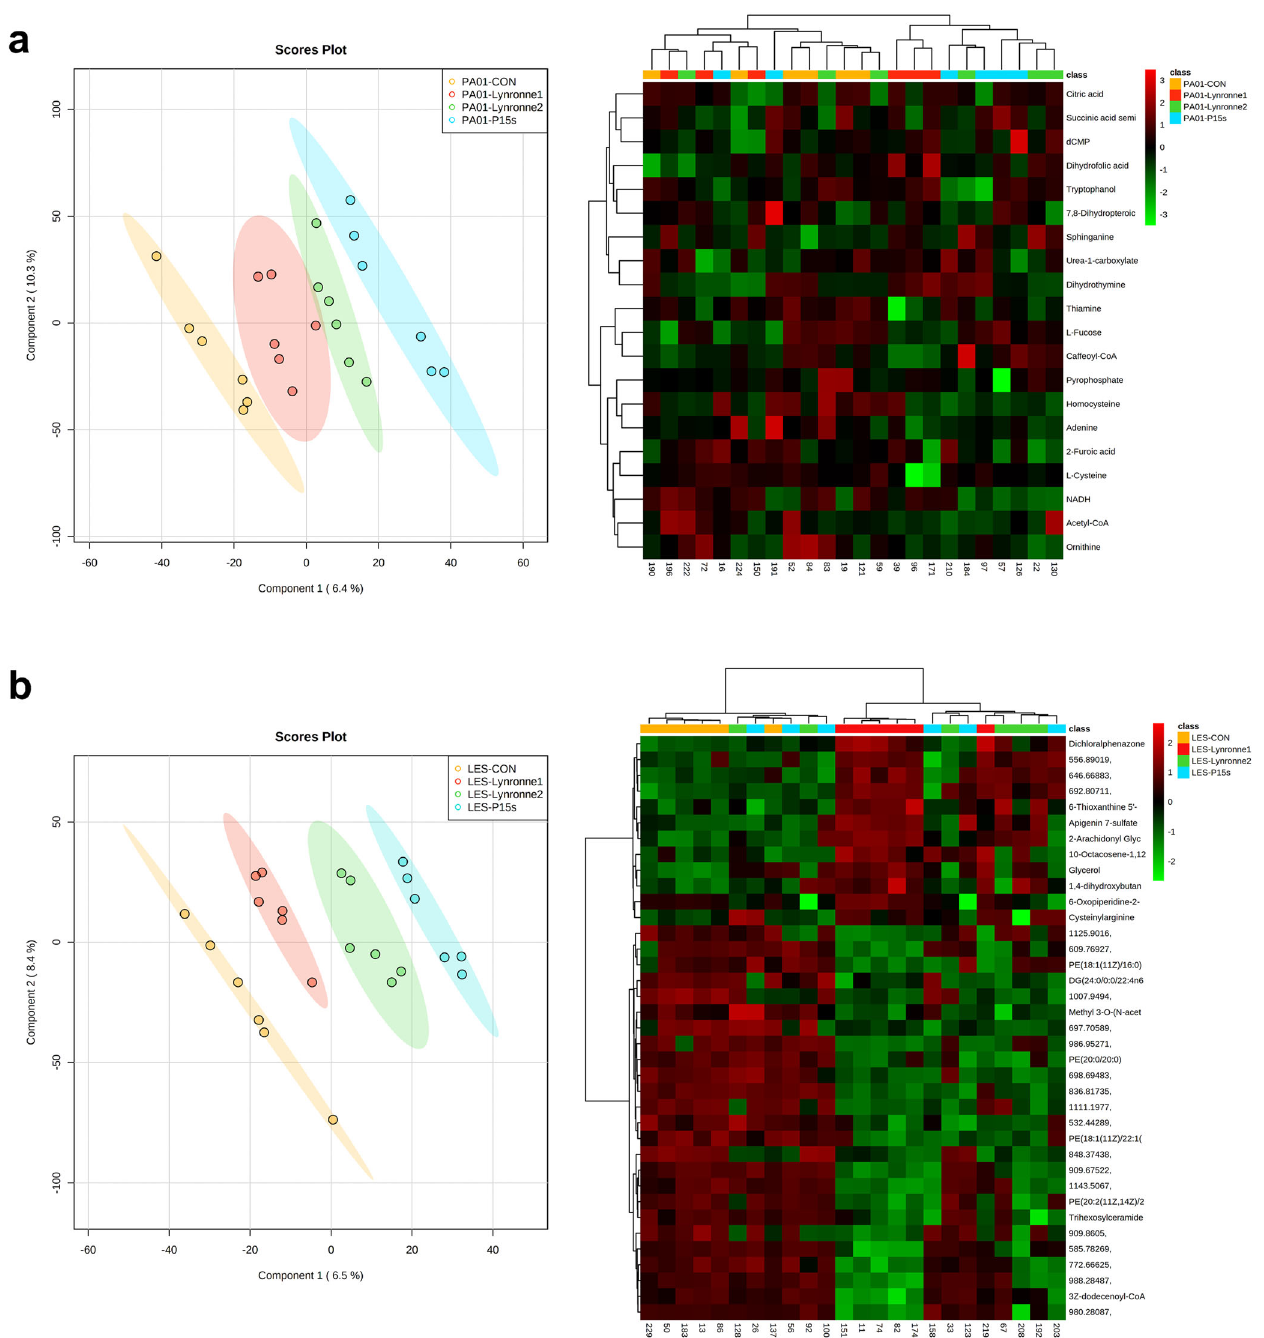
Fig. 6 Peptide-induced metabolic changes in PAO1 and LES431 cells. PLS-DA & hierarchical cluster analysis (HCA): heatmap for negative ionisation fl ow injection electrospray mass spectrometry (FIE-MS) generated based on the top 25 signi fi cant metabolites through one-way ANOVAs, for the peptide metabolite groups (Lynronne 1, Lynronne 2 and P15s) and the untreated ( a ) PAO1 and ( b ) LES431 metabolite group. Metabolites identi fi ed in FIE-MS-negative ionisation 60% after 24 h and 10% after 48 h (Fig. 8a). Following infection using ~1.17 × 10 4 or ~1.32 × 10 3 CFU/larvae PAO1. For the larvae with 10 3 CFU/larvae, survival rate with P15s treatment at 384 mg/ group infected with 10 4 cells; the death rate was 100 % at 24 h (Fig. 8a). Larvae infected with 10 3 cells had 50% survival at 24 h, kg signi fi cantly increased, in comparison to untreated infected larvae (pairwise comparison, P = 0.00467 ) . For statistical analysis, a but 100% of death at 48 h (Fig. 8b). Infected larvae treated with simple pairwise comparison was performed to compare the effect Lynronne 1 (32 mg/kg) or Lynronne 2 (128 mg/kg) showed 100% of an AMP between antimicrobial dosages and the control group. survival at both 10 3 and 10 4 CFU/larvae infection density following Mixing of bacteria and speci fi ed AMP prior to injection was kept to 24 h. Treatment with P15s at 128 mg/kg did not prevent the death less than one minute, therefore, would not affect signi fi cance as of larvae following infection with 10 4 CFU/larvae, however, time-kill kinetics data for all AMPs showed complete kill >50 min treatment with P15s at 384 mg/kg presented a survival rate of